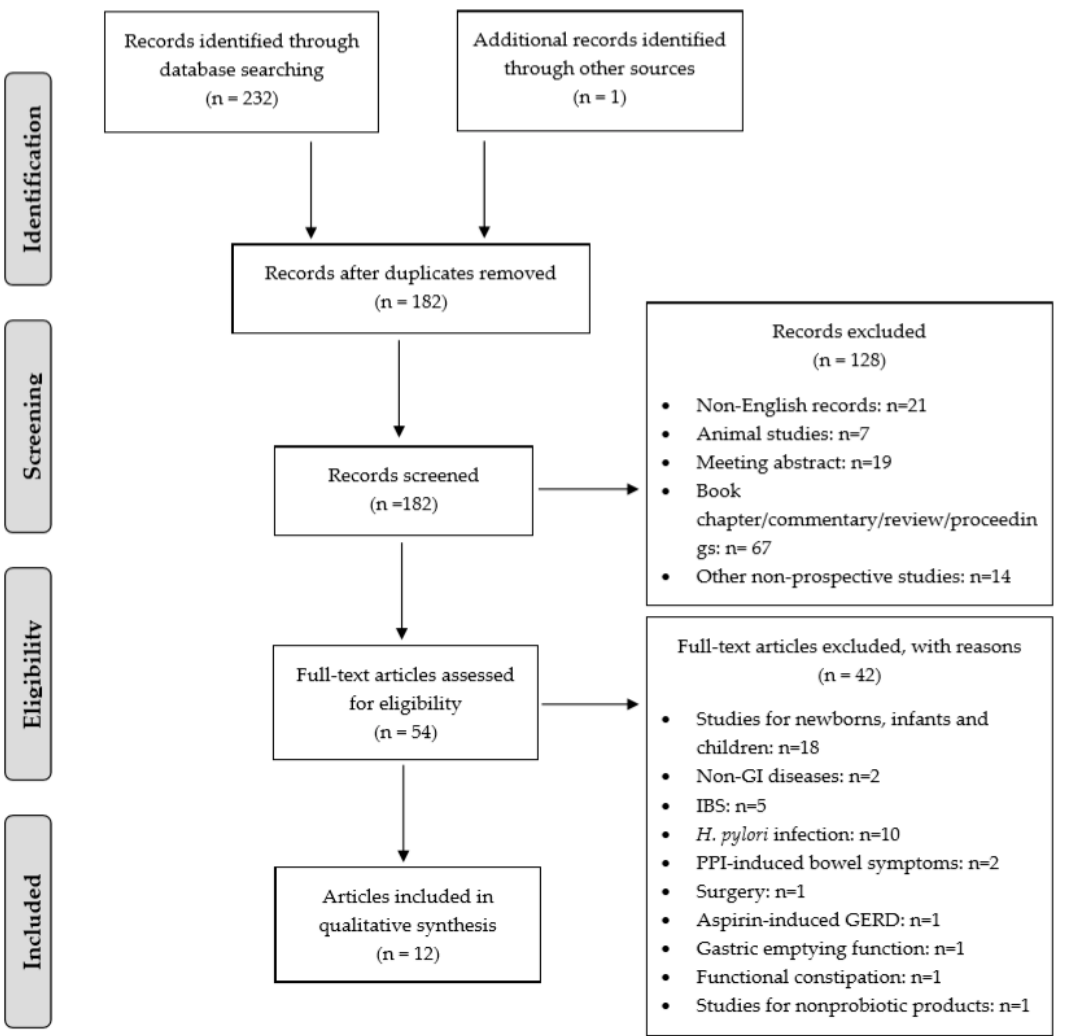
Figure 1. Preferred Reporting Items for Systematic Reviews and Meta-Analyses study flow diagram. Abbreviations: non-gastrointestinal (non-GI), irritable bowel syndrome (IBS), proton pump inhibitor (PPI), gastroesophageal reflux disease (GERD).